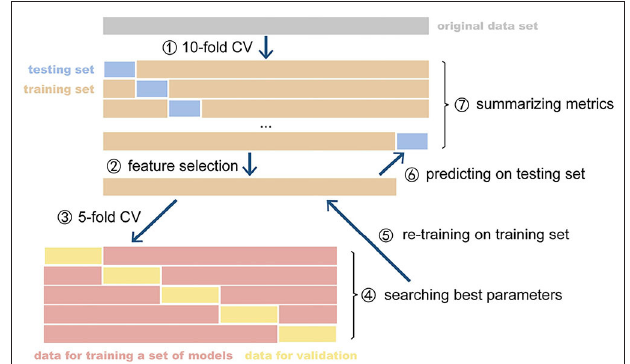
FIGURE 2 | The CV and nested CV processes. CV, cross-validation. The parameter optimization of model was implemented on the inner CV and retrained optimized model was evaluated on the outer CV. The metrics of all fold were summarized as the expected performance of the